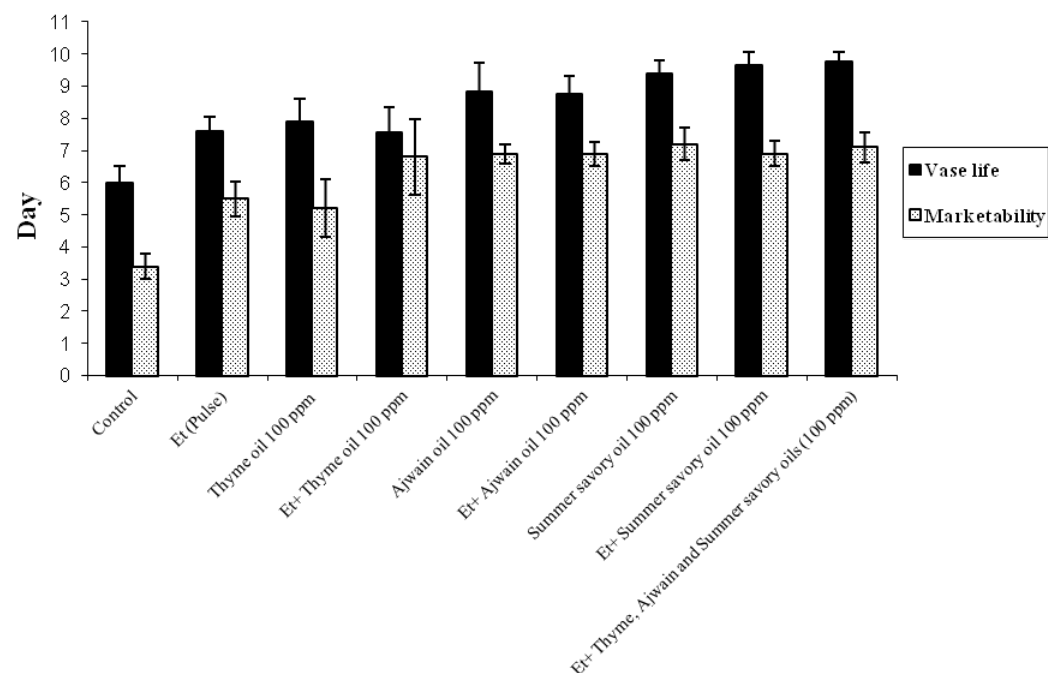
Fig. 4. Effect of pulse Et and different concentration of essential oils (100 ppm) alone and in combination treat- ment on vase-life and marketability of carnation cut flowers (cv. ‘Yellow